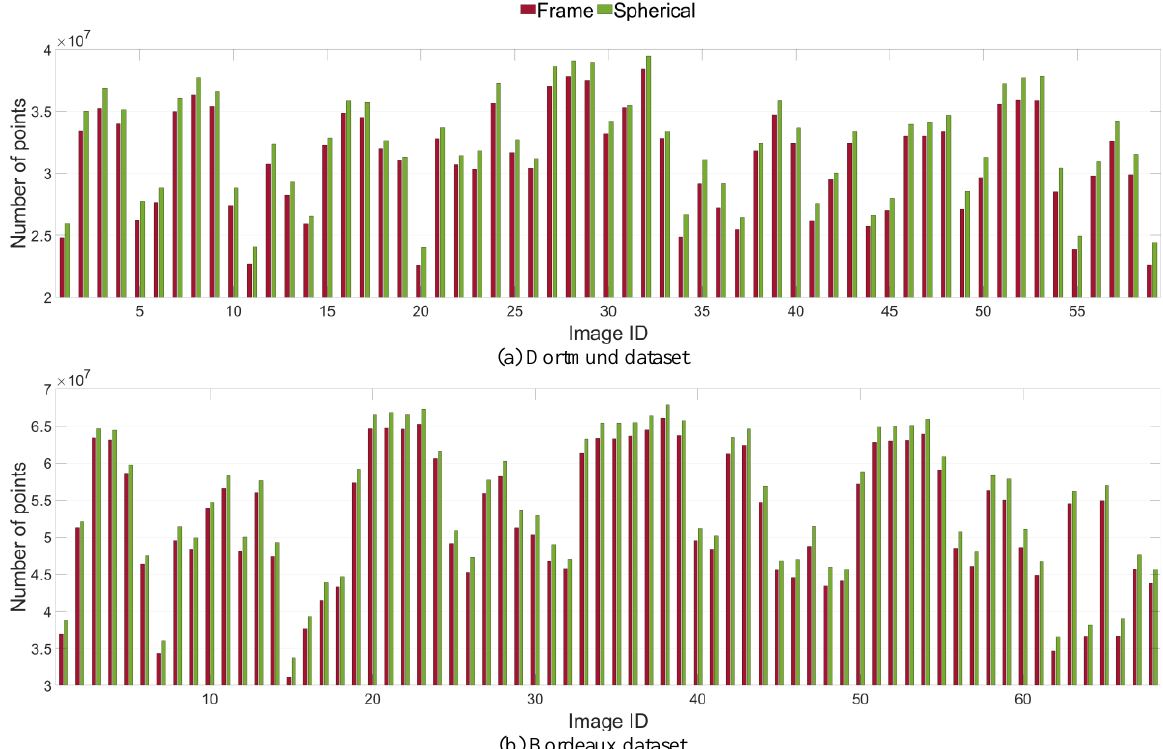
Figure 5 . Evaluation of the completeness of generated point clouds for the Dortmund and Bordeaux datasets using the proposed spherical matching compared to frame-based.